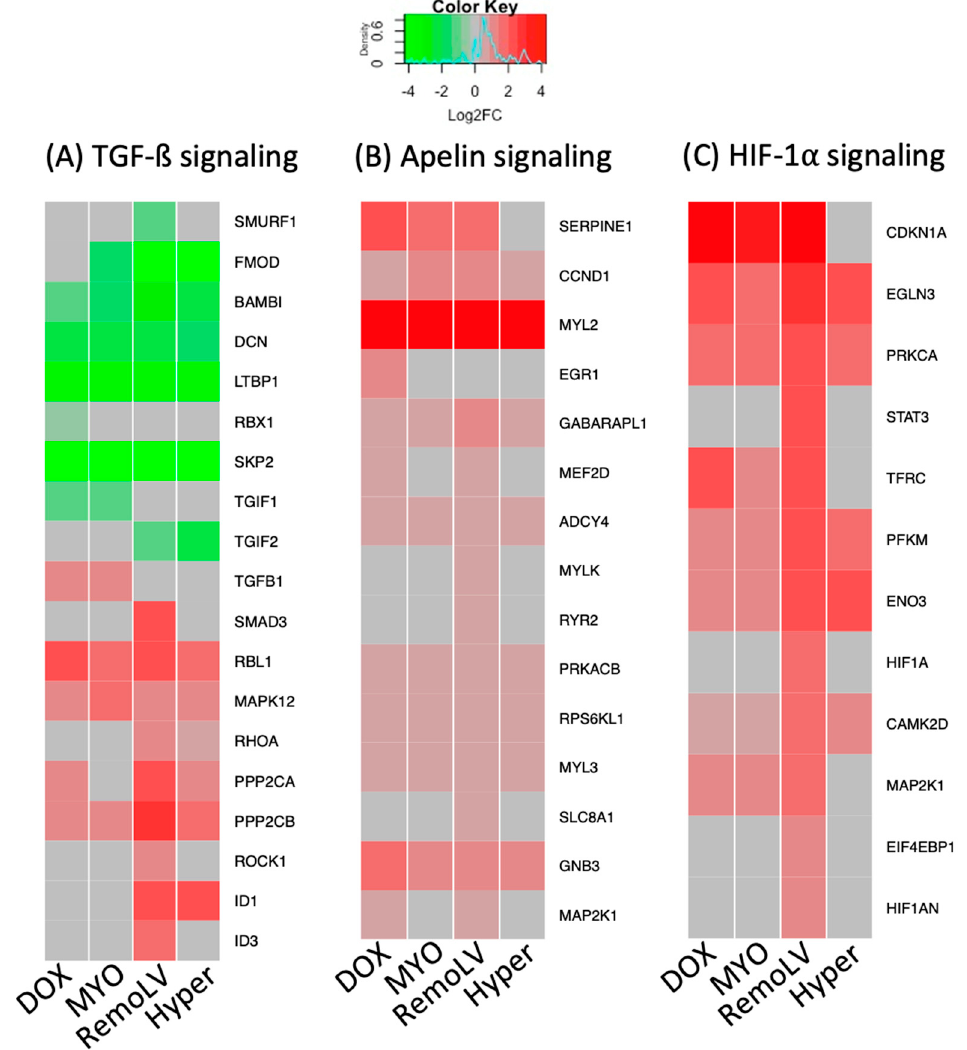
Figure 3. The heatmaps of differentially regulated genes in regulated pathways across all models of myocardial remodeling. The heat maps show the expression of genes compared to untreated control in the transforming growth factor beta (TGF-ß) signaling pathway ( A ), apelin signaling pathway ( B ), and hypoxia-inducible factor 1-alpha (HIF-1 alpha) signaling ( C ) in all treatment groups. Red = upregulation; green = downregulation; gray = non-significant changes. The treatment groups DOX (N = 5), MYO (N = 5), RemoLV (N = 3) and Hyper (N = 3) are relative to control animals (N = 3). (Significance for p < 0.05, moderated t-statistics adjusted for multiple